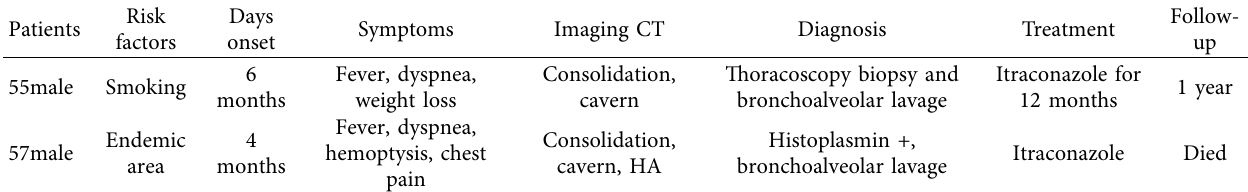
Table 2: Patients with chronic histoplasmosis.